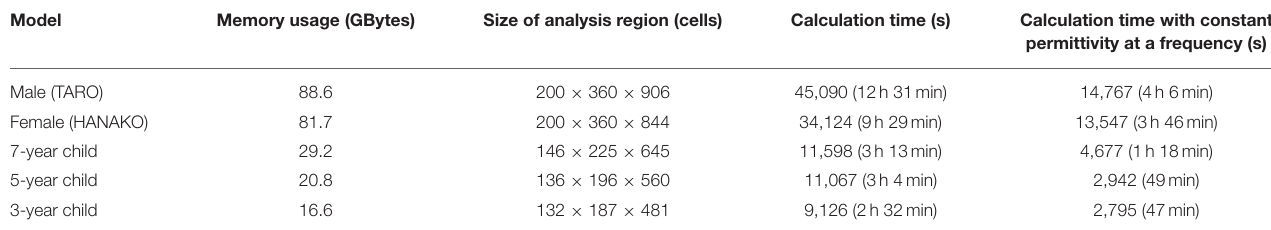
TABLE 4 | Calculation time and memory usage for each model. Model